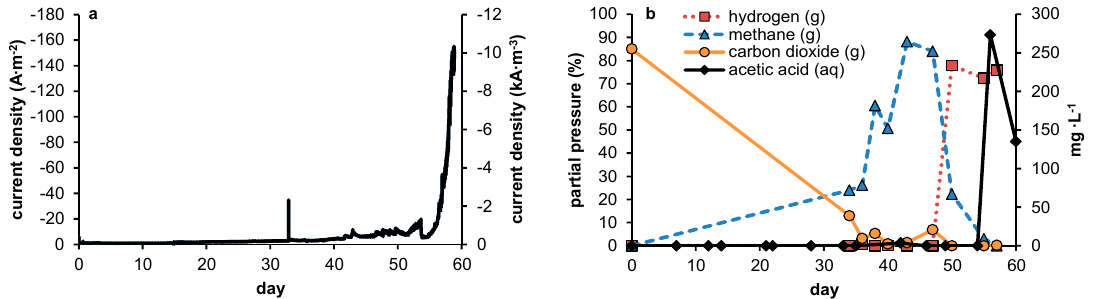
Figure 2. ( a ) current plot of the − 900 mV vs. Ag/AgCl controlled biocathode throughout 57 days of operation; ( b ) Headspace composition throughout the experiments showed gradually increasing methane partial pressures, accompanied by decreasing levels of carbon dioxide. In the last phase of the experiment, hydrogen replaced all other gases and subsequently acetate formation took place.